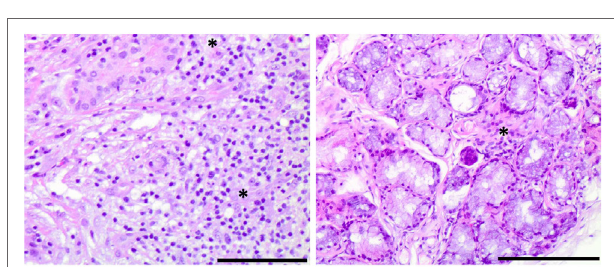
FIgURe 4 | Histological findings of Sjögren’s syndrome in an interleukin 12 receptor beta 1-deficient male. Right panel: lymphocytic infiltrates with periductal distribution in a lacrimal gland biopsy section, stained with hematoxylin and eosin (10 × magnification, bar size: 0.5 µg) Left panel: focal lymphocytic infiltration in a minor salivary gland biopsy section, stained with hematoxylin and eosin (10 × magnification, bar size: 0.5